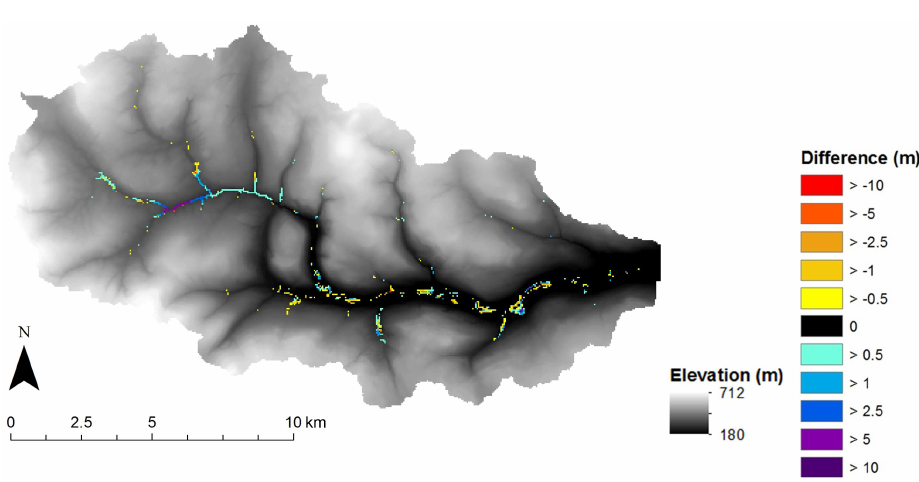
Figure 5. DEM of difference (DOD) between 1000-year random 1 and the 0.25h × 5km resolution